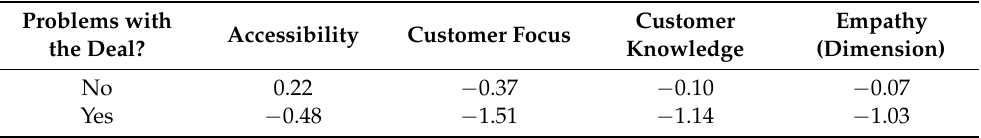
Table 13. Average service quality score for groups with and without problems during the timber deal. Differences between groups are significant on all items ( p <